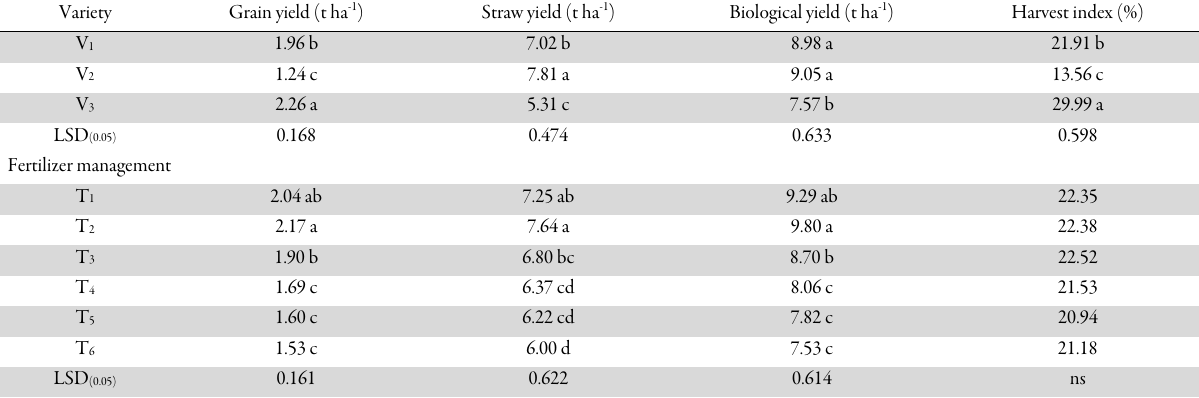
Table 4. Effect of varietal variation and fertilizer management on yield and harvest index of rice